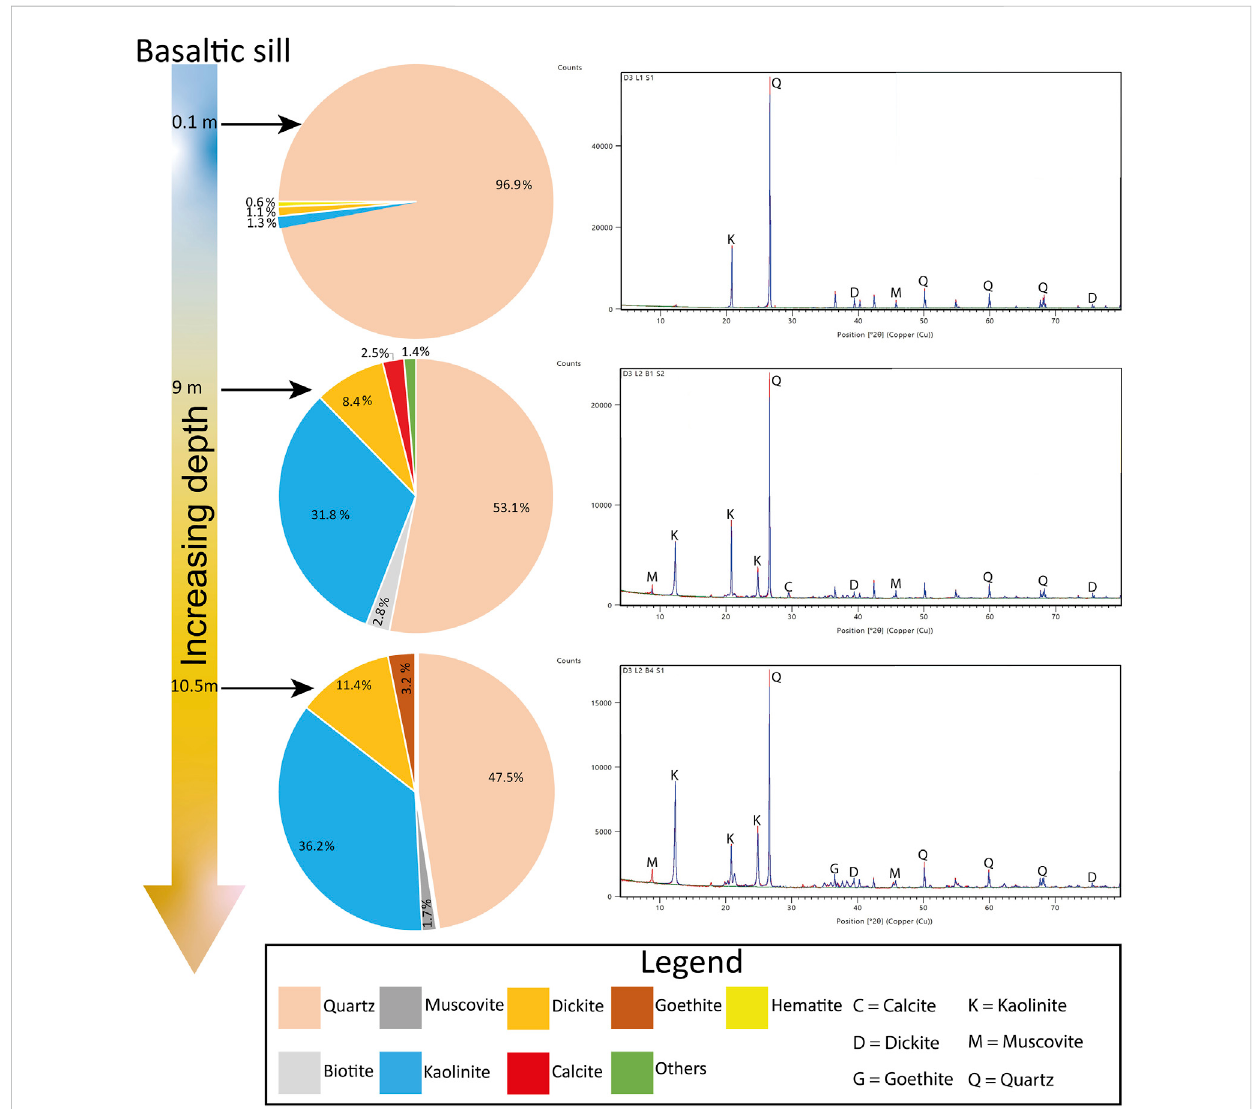
FIGURE 4 Results of the bulk XRD analysis showing the variations in composition of the studied sandstones away from the sill